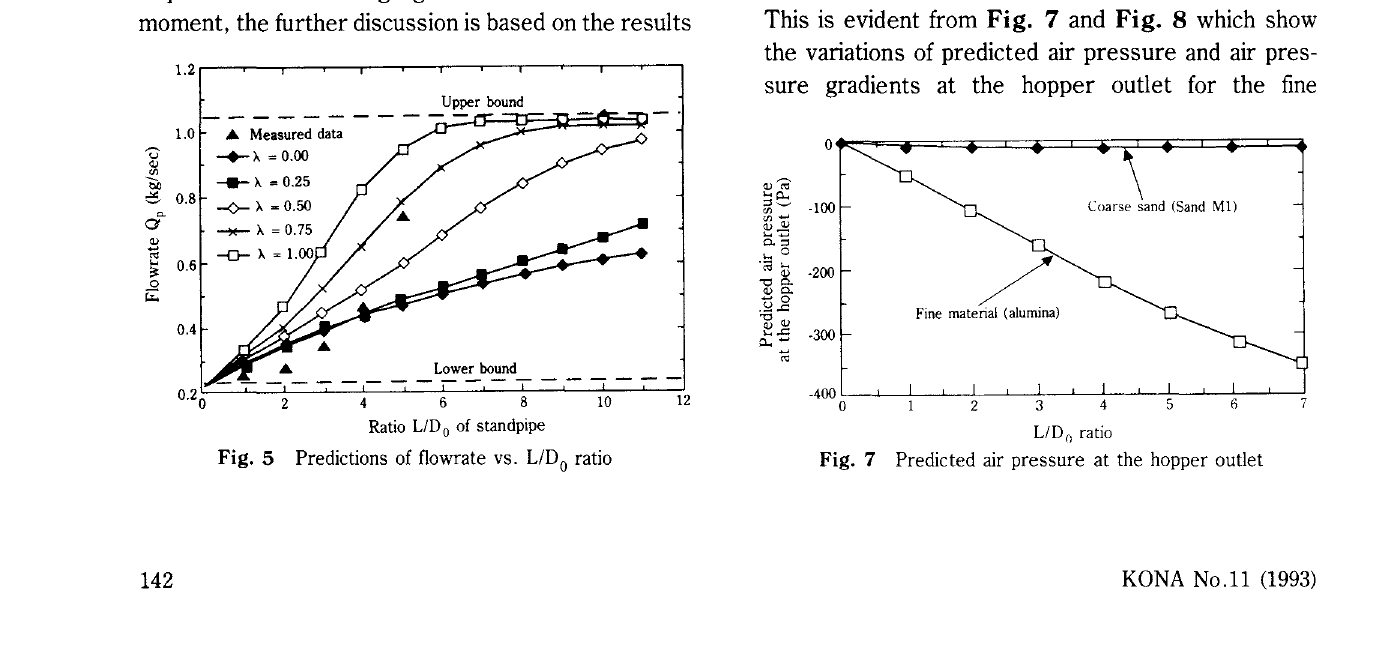
Fig. 6 Enhancement factor for different